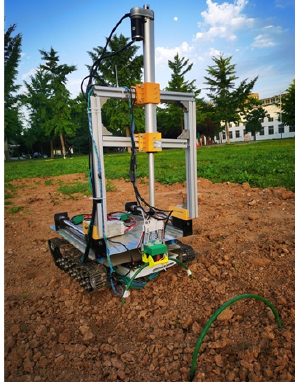
Figure 12. The automatic cuttage device for an arch shed pillar.